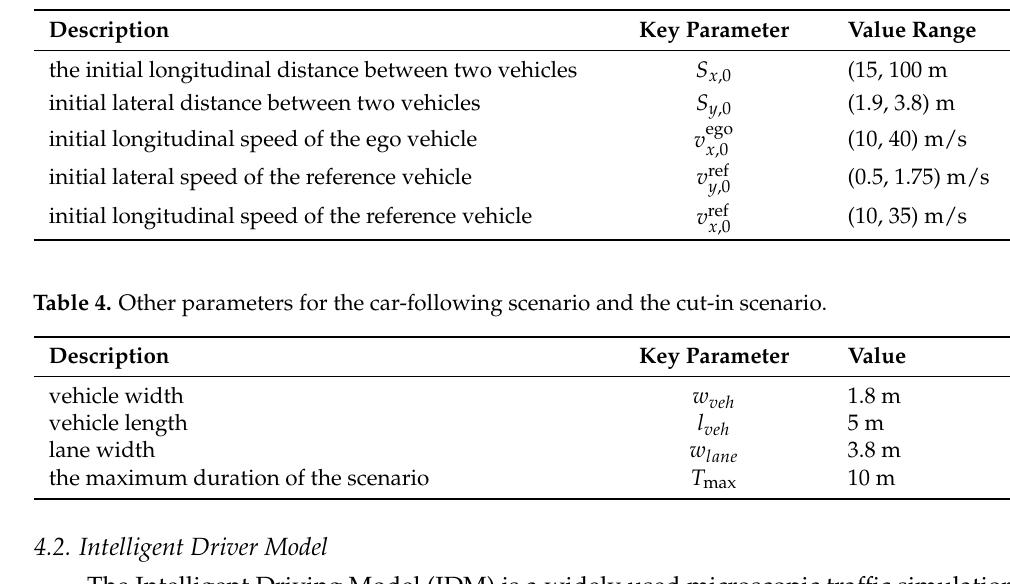
Table 3. Parameter settings for the simplified cut-in scenario.